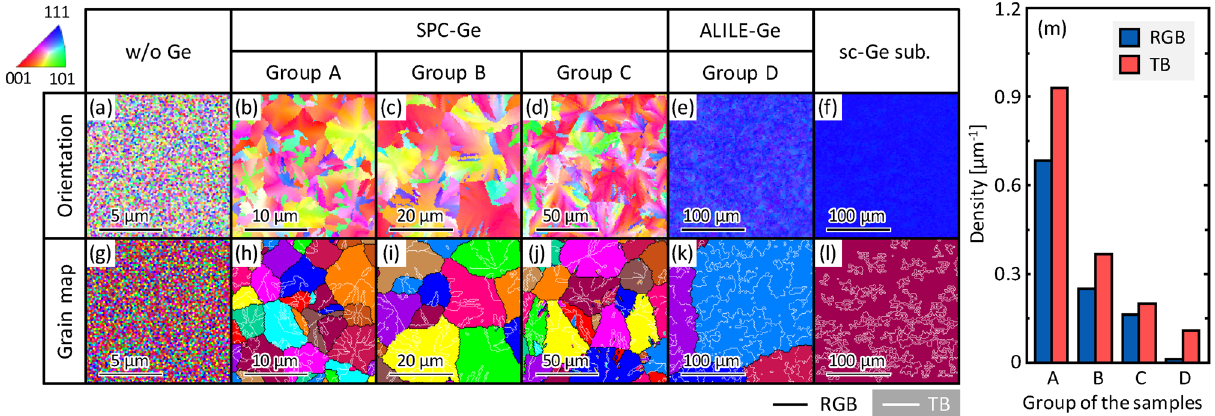
Figure 4. EBSD analyses of GaAs layers. ( a – f ) Crystal orientation and ( g – l ) grain maps of ( a , g ) GaAs layer grown on glass without Ge seed layer, ( b , h ) sample in Group A ( T anneal = 375 °C), ( c , i ) sample in Group B ( T anneal = 375 °C), ( d , j ) sample in Group C ( C As = 1.2 × 10 20 cm −3 ), ( e , k ) sample in Group D ( t AE = 3 min), and (h,l) GaAs layer grown on sc-Ge(111) wafer. Color in crystal orientation maps indicates crystal orientation (refer to legend in inset). Each colored area in grain maps corresponds to one grain. Solid black lines represent random grain boundaries (RGBs) surrounding grains, and white solid lines represent twin boundaries (TBs). ( m ) Density of RGBs and TBs determined by grain maps shown in ( h – k